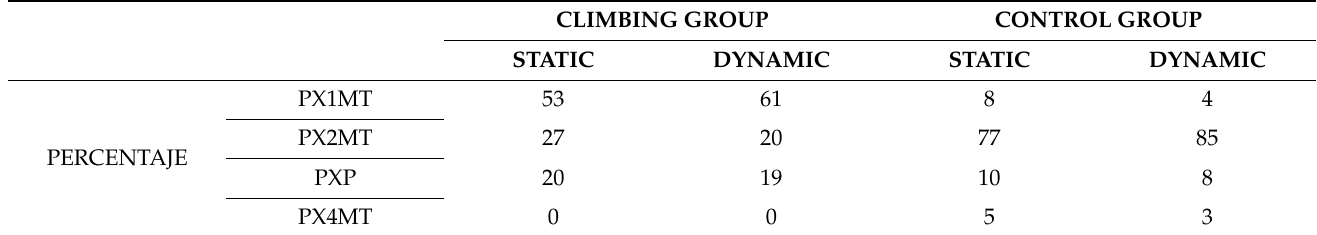
Table 4. Percentage of occurrence of plantar pressures.